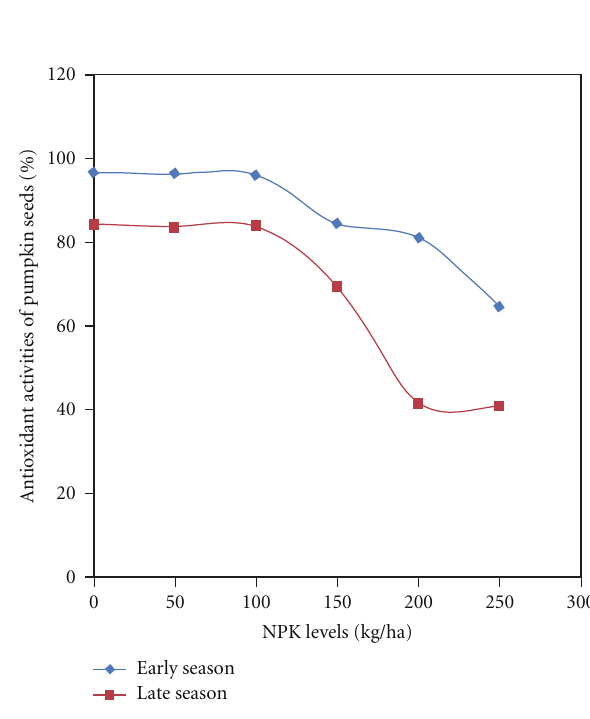
Figure 3: Carbohydrates content of pumpkin seeds as a ff ected by season by NPK fertilizer interaction.